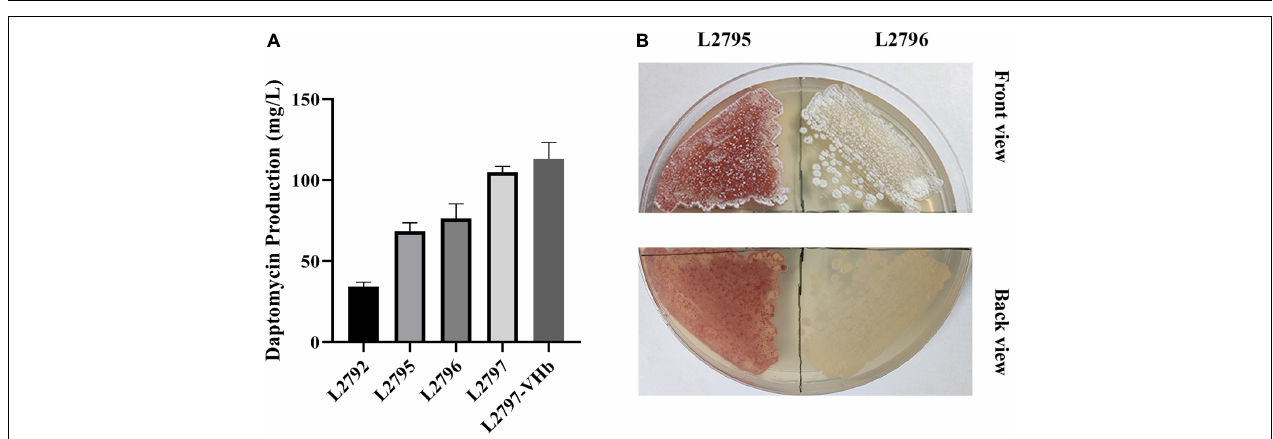
FIGURE 3 | Improving daptomycin production and quality by regulatory pathway reconstruction, pigment removal, multicopy BGC, and heterologous expression of VHb in a stepwise manner. (A) The daptomycin production of different strains obtained in a stepwise manner. The culture samples were collected at 144 h and daptomycin production was analyzed by HPLC. The cultures were performed in triplicate. L2792, the resultant strain by deleting orf3244 and orf3242 in the initial strain L2790; L2795, the resultant strain by deleting gene phaR and arpA in L2792; L2796, the resultant strain by deleting gene orf3265 and orf3266 in L2795; L2797, the resultant strain by introducing the extra copy of daptomycin BGC into L2796; L2797-VHb, the resultant strain by introducing a vgb2 gene into L2797. (B) Phenotype of L2795 and L2796 cultured on R5 medium.